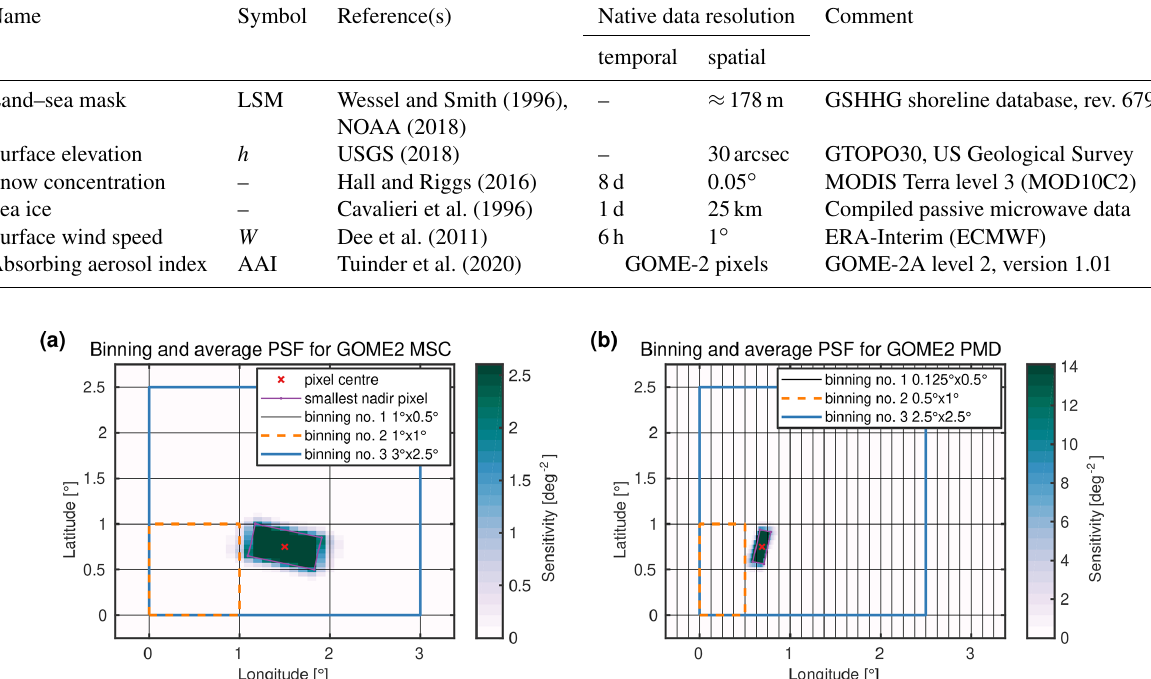
Figure 4. Illustration of average MSC (a) and PMD (b) point spread functions (PSFs) used as convolution kernels for LSM, elevation, sea ice and snow concentration maps. The PSFs correspond to a nominal GOME-2 swath width of 1920km. The highest resolutions for MSC and PMD lower threshold maps are 0.1 ◦ × 0.05 ◦ and 0.0125 ◦ × 0.05 ◦ , respectively, and denoted as binning no. 1 as in Table